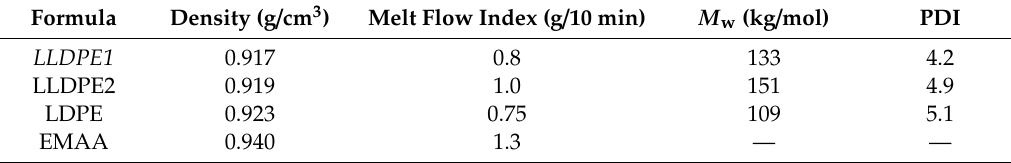
Table 1. Typical molecular characteristics and rheological properties of polymers.